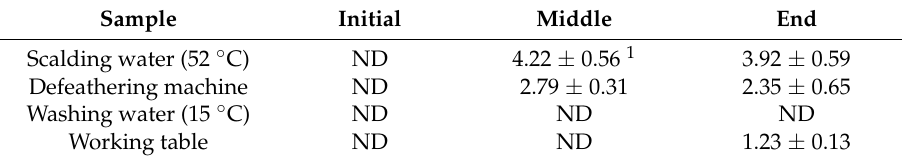
Table 4. Campylobacter spp. counts in the slaughterhouse environment at different times during